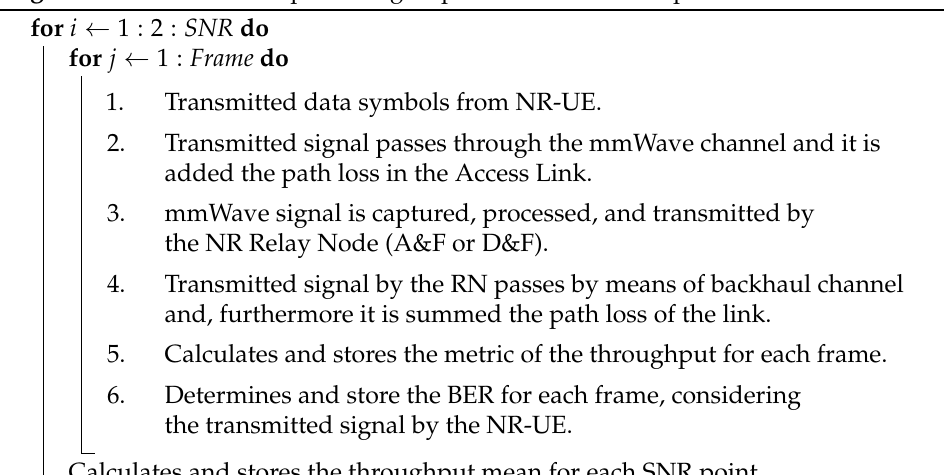
Algorithm 2: Monte-Carlo processing loop in the link-level co-operative